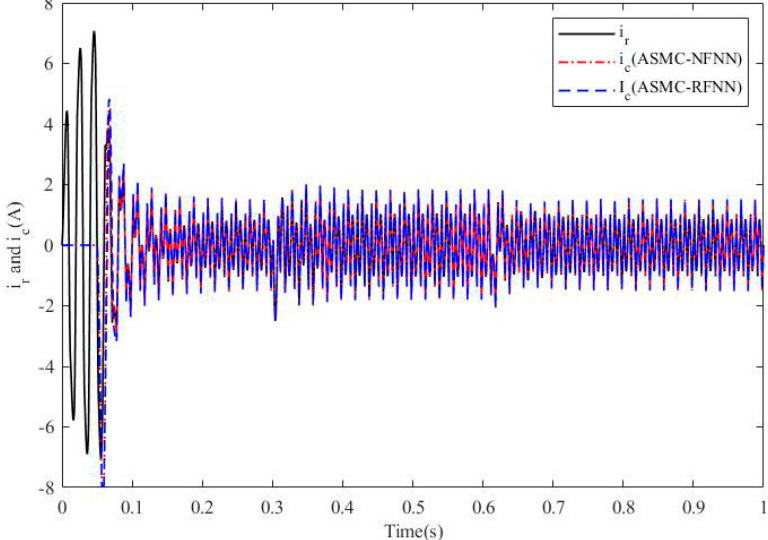
Figure 15. Current tracking curves (load increases at 0.3 s, load decreases at 0.6 s).